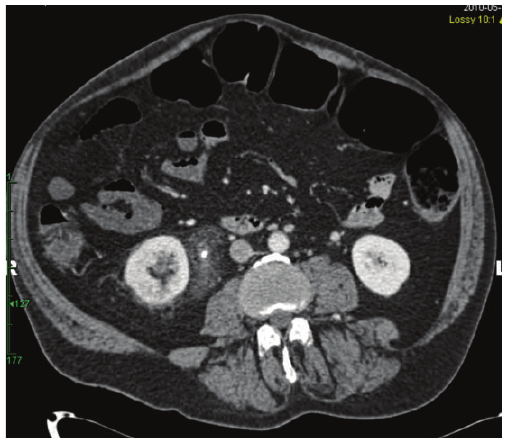
Figure 2: CT abdomen with contrast demonstrates a wedge-shaped segment of low attenuation in the posterior, lower pole of the right kidney consistent with pyelonephritis. Please note the retained right ureteral stent and periureteral stranding.